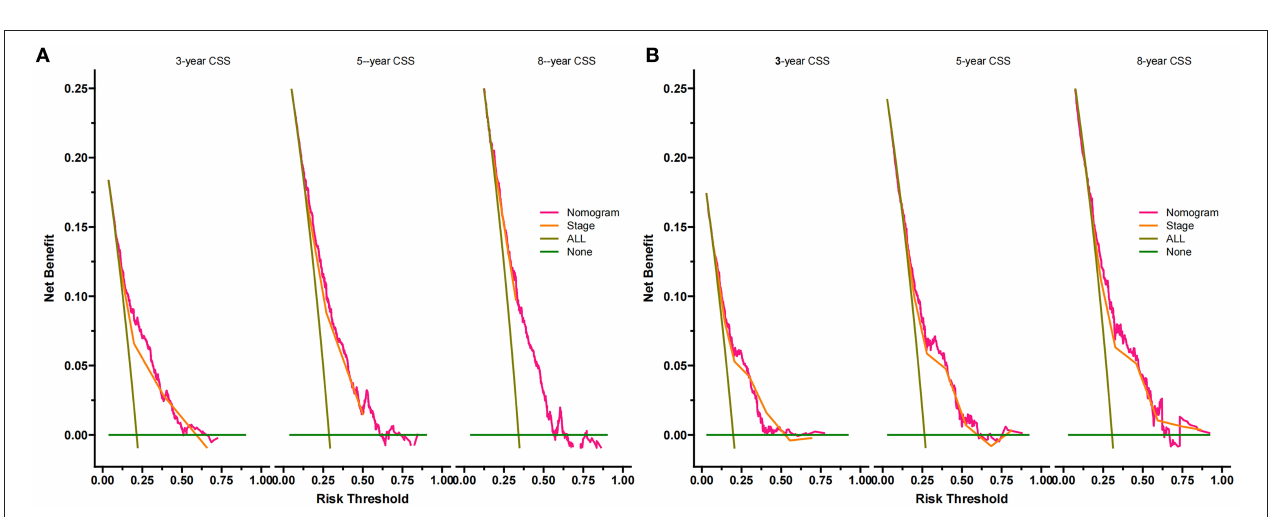
FIGURE 5 | Decision curves of the nomogram predicting CSS in the training set (A) and the validation set (B) . The x-axis is the threshold probability, and the y-axis is the net benefit. The green line indicates that no patients have died, and the dark green line indicates that all patients have died. When the threshold probability is between 10 and 50%, the net benefit of the model exceeds all deaths or no